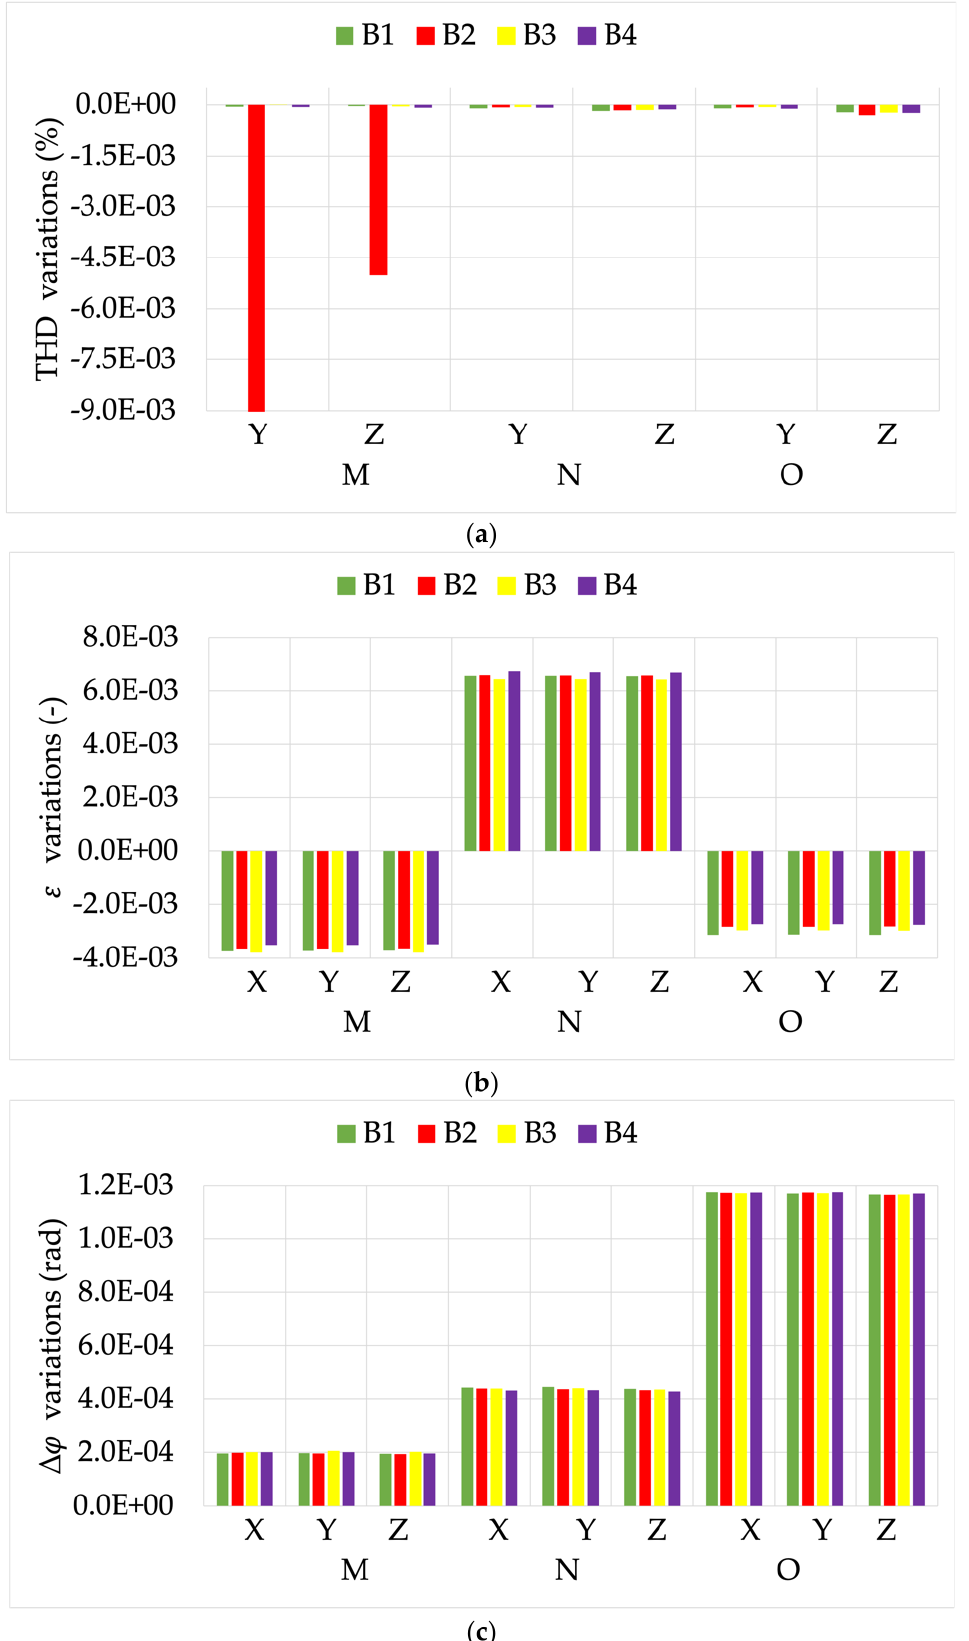
Figure 15. ( a ) THD, ( b ) 𝜀 , and ( c ) ∆𝜑 variations, from the tests vs. burden and position, for RC R2.